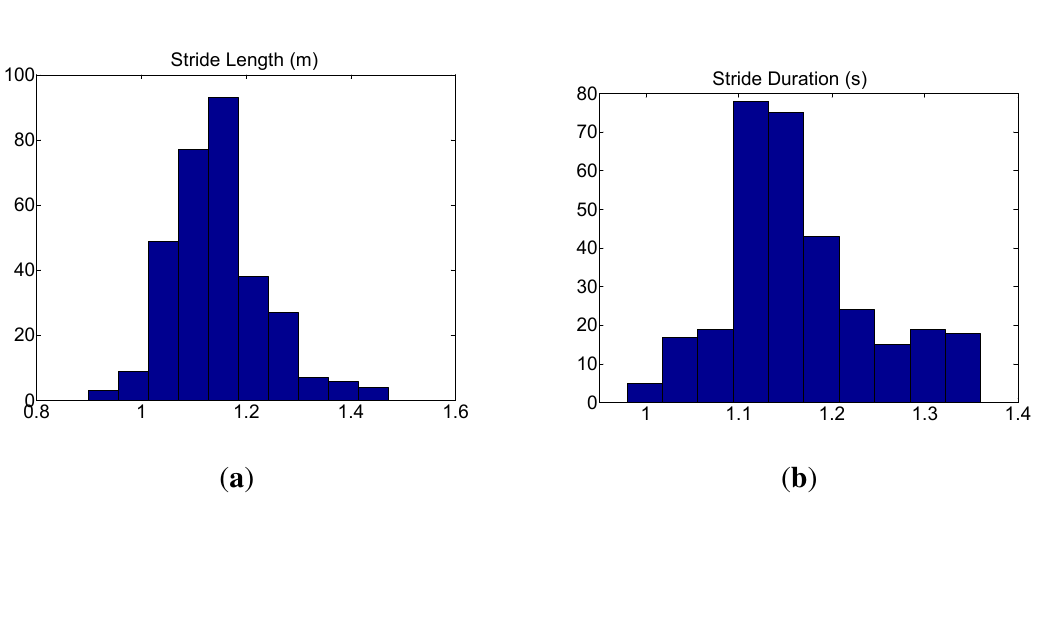
Figure A1. Histograms of all estimates of stride length, stride duration, stride velocity, horizontal stride symmetry and vertical stride